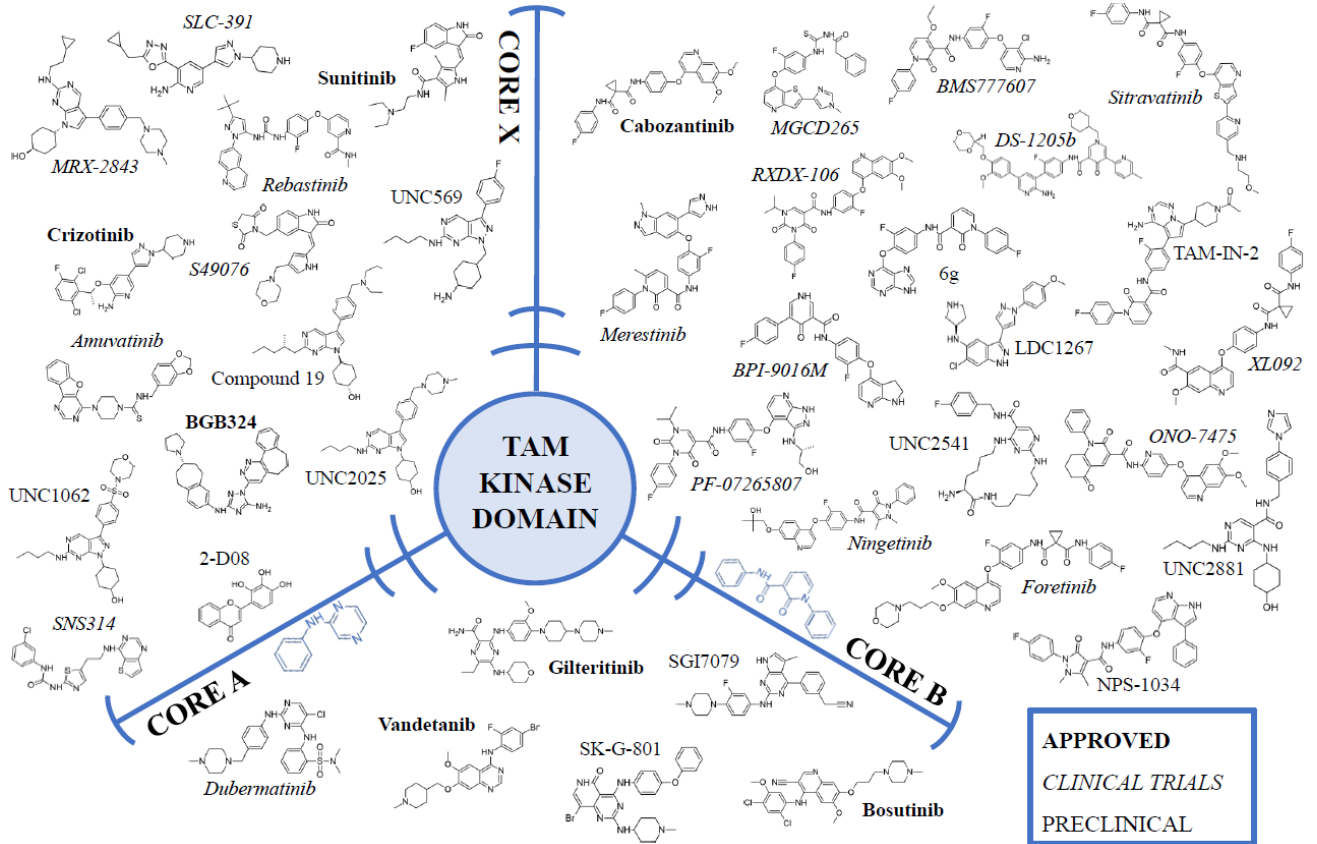
Figure 2. Different structures of TAM family kinase inhibitors. TAM receptors are divided into three groups, based on their base core structure: CORE-A compounds, with hydrogen bond acceptor–substituted phenyl group linked to a hinge-binding heterocycle with a solubilising group; CORE-B compounds, with heterocycle (hinge-binding) optionally ortho-fluoro phenyl group (binding DFG motif), 2–4 hydrogen donors/acceptors, and a phenyl group (or para-fluoro phenyl) (binding to allosteric hydrophobic pockets); and CORE-X compounds, that cannot be clearly assigned to either -A, or -B groups, as they present only partial structural similarity to other cores, or present completely different lead structures. Compounds approved for treatment are presented in bold, compounds currently in clinical trials are presented in italics, and compounds that did not enter the clinical phase are presented in plain text.